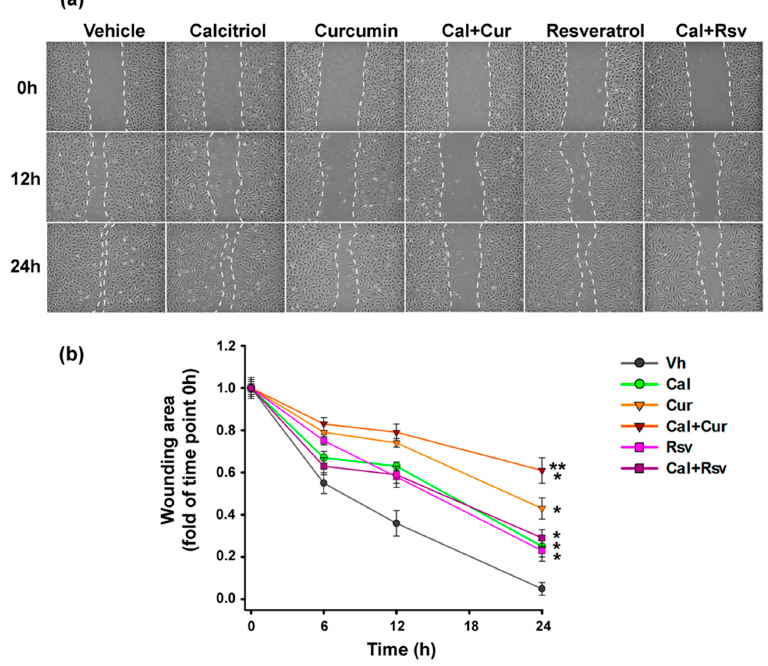
Figure 8. The combination of Calcitriol+Curcumin inhibits in vitro the migratory activity of EA.hy926 cells. ( a ) Representative bright-field images (10×) showing the effects of calcitriol (Cal, 10 nM), curcumin (Cur, 10 μ M), resveratrol (Rsv, 10 μ M), or the combinations of calcitriol with curcumin (Cal+Cur) or with resveratrol (Cal+Rsv). The profile of the wound is delineated for better visualization. ( b ) Wound closure expressed as the remaining area uncovered by the cells. The scratch area at time point 0 hours was set to 1. Scratch-wound closure was monitored over time (0, 6, 12, and 24 h) in triplicate experiments, N = 9 measures per treatment; * p < 0.05 vs. vehicle-treated cells (ethanol 0.1%), ** p < 0.05 vs. calcitriol or curcumin alone.